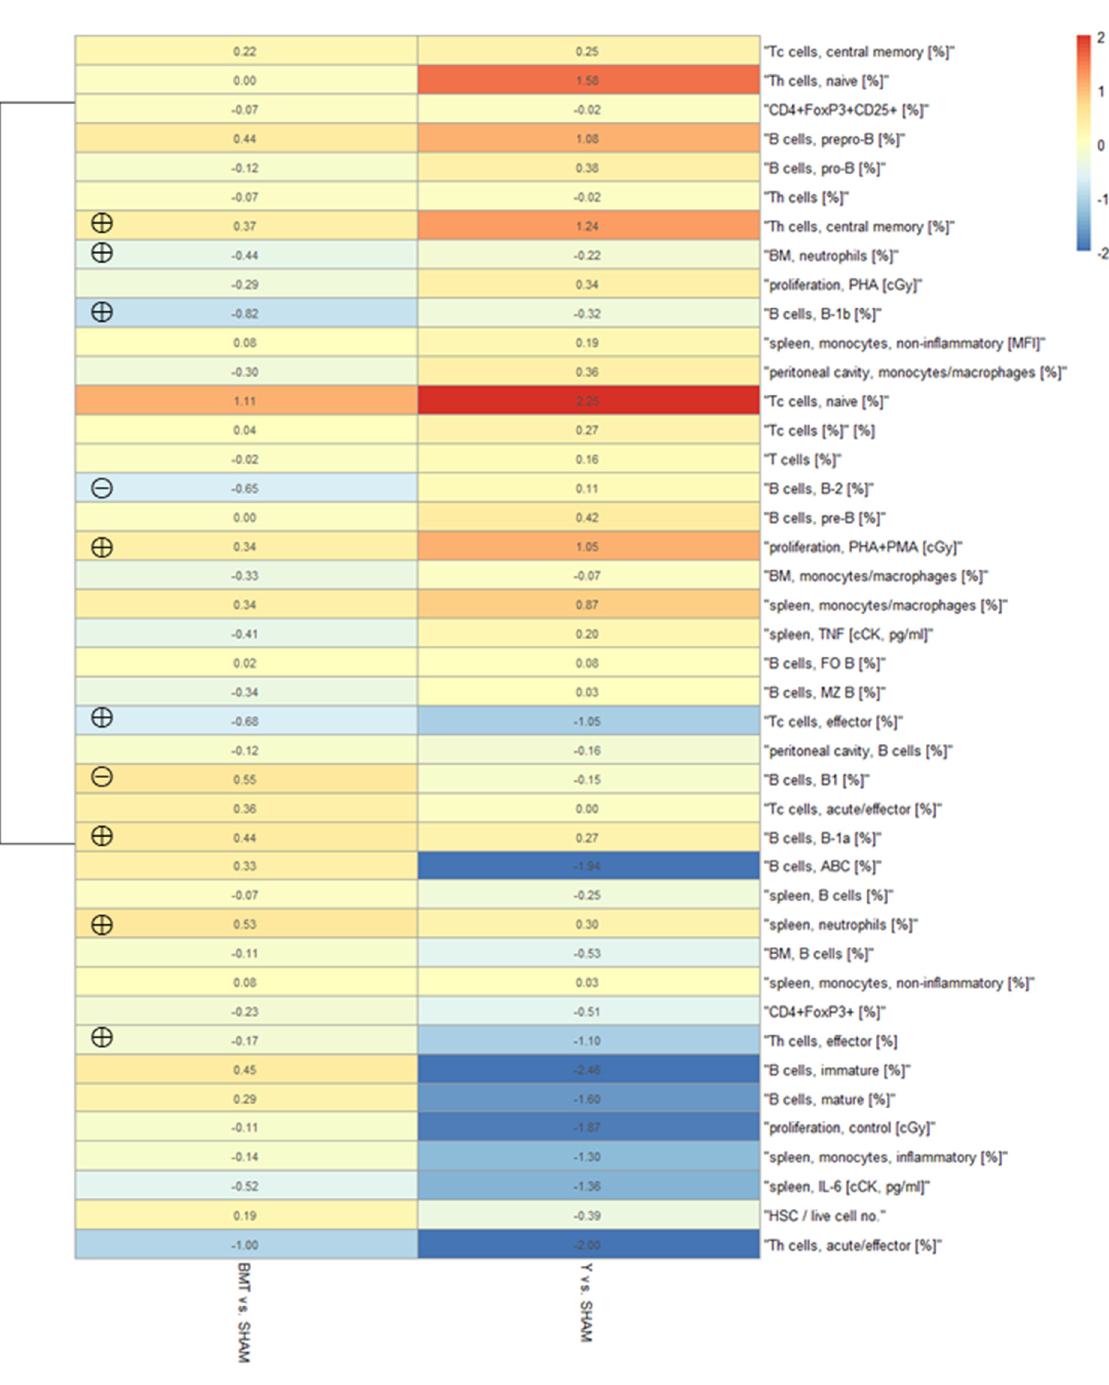
Figure 2. Heatmap of the analyzed parameters. The types of analysis are shown along the right axis, group comparison along the bottom axis. Red results indicate that the result is higher than in the SHAM group, and blue results indicate that the result is lower than in the SHAM group. Numbers in the boxes indicate the factor: 1 means the result is two times higher, and − 1 indicates that the result is two times lower. Legend: BMT—transplanted aged mice, SHAM—aged control mice, Y—young control mice, ⊕ rejuvenating effect, ⊝ adverse effect.